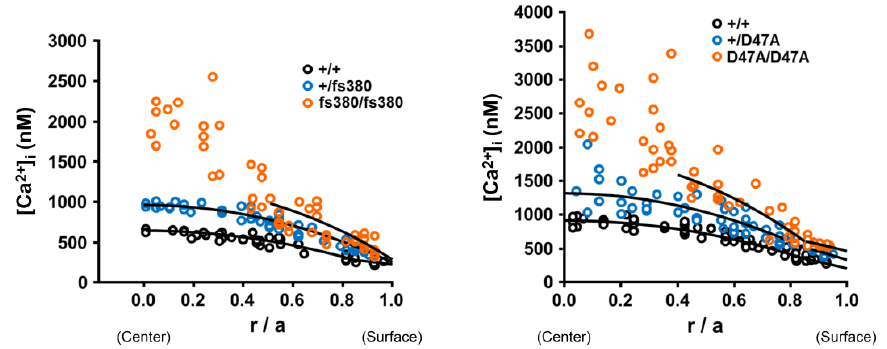
Figure 2. Intracellular calcium ion concentrations are increased in Cx46fs380 and Cx50D47A lenses. Graphs show the intracellular calcium concentrations ([Ca 2+ ] i ) in wild type (black circles), heterozygous (blue circles) and homozygous (orange circles) Cx46fs380 (left) and Cx50D47A (right) lenses as a function of radial distance from the lens center (r; cm), normalized to the lens radius (a; cm). The curves represent the best fit to the data based on the model described in Gao et al. [24]. Reproduced from Gao et al. (Figure 6J) [3] and Berthoud et al. (Figure 6D) [21].